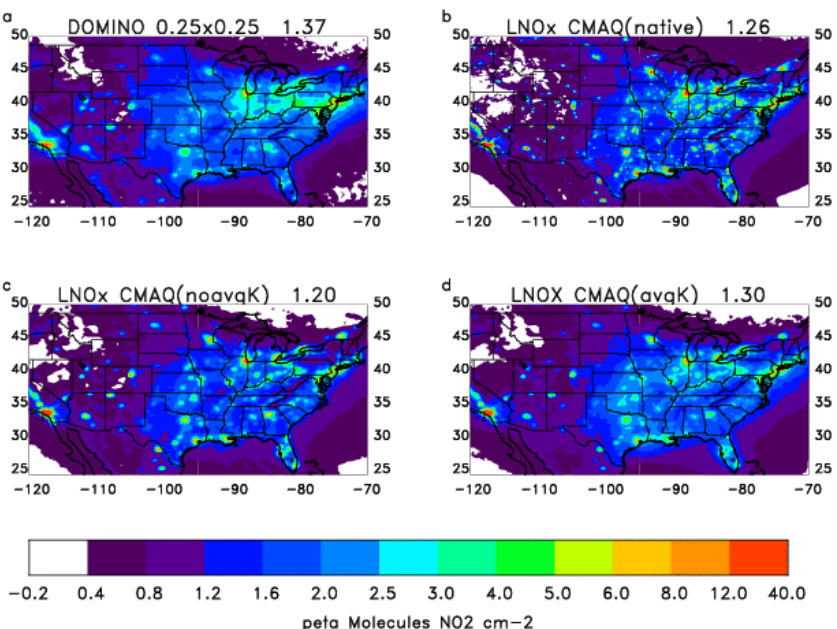
Fig. 6 . Mean tropospheric NO 2 column for 1 June 2006 to 30 August 2006. (a) Version Fig. 6. Mean tropospheric NO 2 column for 1 June 2006 to 30 August 2006. The upper left panel shows the mean version 2.0 DOMINO 2.0 DOMINO column, (b) CMAQ column from simulation LNO x on the native 12-km column. The upper right panel shows the mean CMAQ column from simulation LNO x on the native 12-km grid. The lower left (right) panel grid, (c) CMAQ column from simulation LNO x on the 0.25°x0.25° DOMINO grid before shows the mean CMAQ column from simulation LNO x on the 0.25 ◦ × 0.25 ◦ DOMINO grid without (with) processing by the averaging processing by the averaging kernel, and (d) CMAQ column from simulation LNO x on the 0.25°x0.25° DOMINO grid after processing by the averaging kernel.